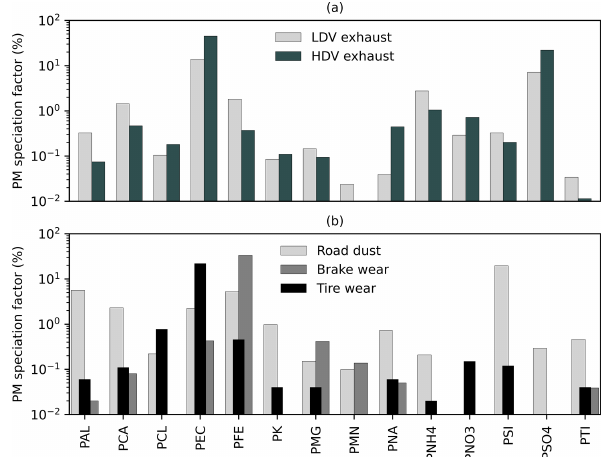
Figure 6. PM chemical speciation factors for (a) exhaust emissions from light and heavy vehicles (b) road-dust resuspension, brake wear, and tire wear. Data derived from US EPA SPECIATE 5.1 (US EPA, 2020; Eyth et al., 2020).